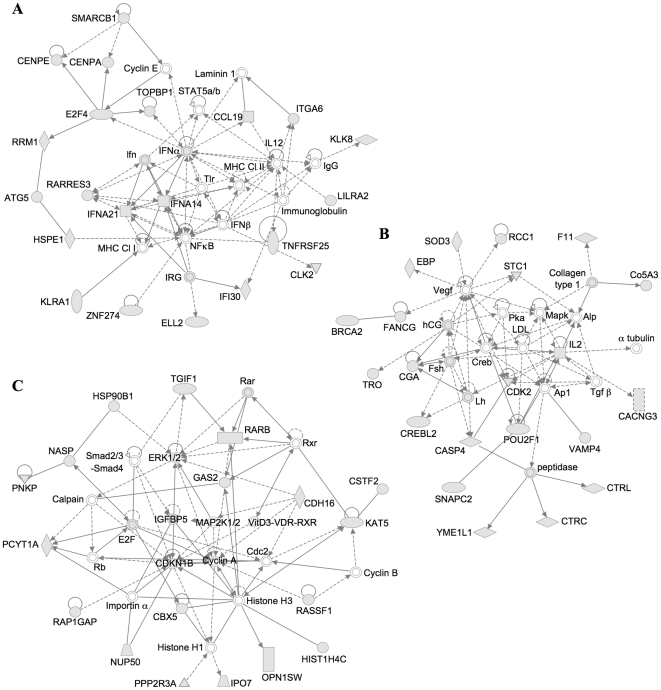
Network diagrams illustrating prominent regulatory relationships among AP2α-bound genes.Grey-filled shapes represent genes significantly bound by recombinant AP2α on the PBM. Main functions related as these networks, as constructed and classified by the Ingenuity Analysis Software are cellular development, cell-to-cell signaling and interaction, and embryonic development (A), cell death, cancer and genetic disorder (B), or cancer, cell cycle and embryonic development (C).